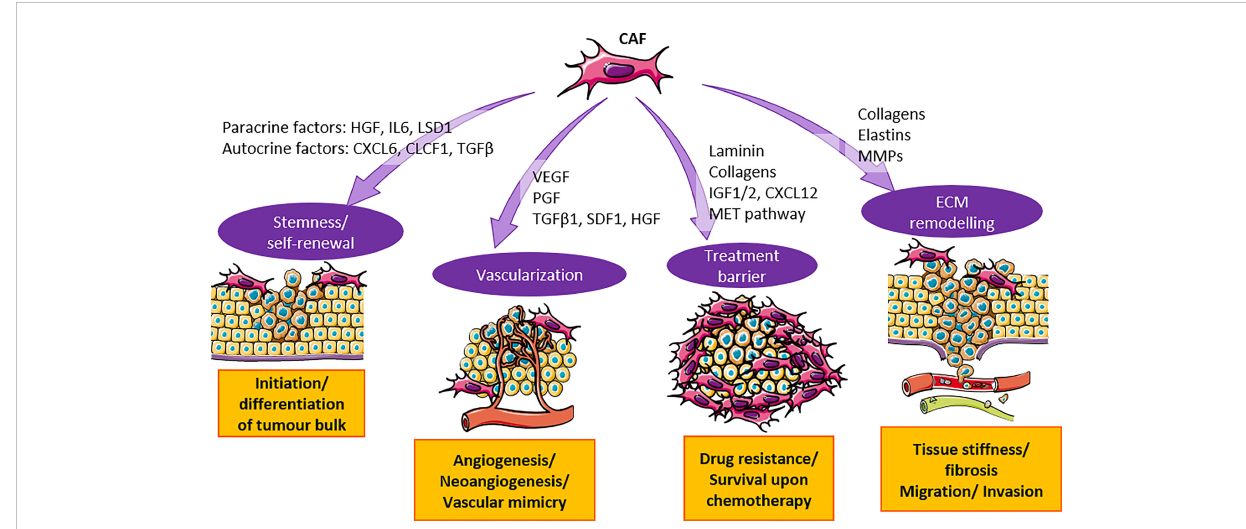
FIGURE 1 CAF contributes to the tumorigenesis in HCC through secretion of cytokines and activation of signaling pathways. CAF secretes cytokines such as HGF, IL6, TGF- b and others to promote cancer cell stemness and vascularization. They also activate MET and ECM pathway to substantiate treatment barrier and ECM remodeling. Orchestration of events mentioned above promote HCC